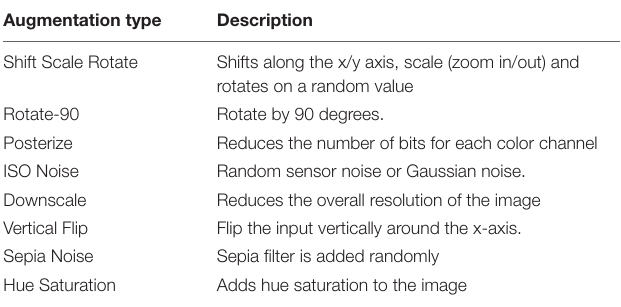
TABLE 1 | Image augmentation types and its description.